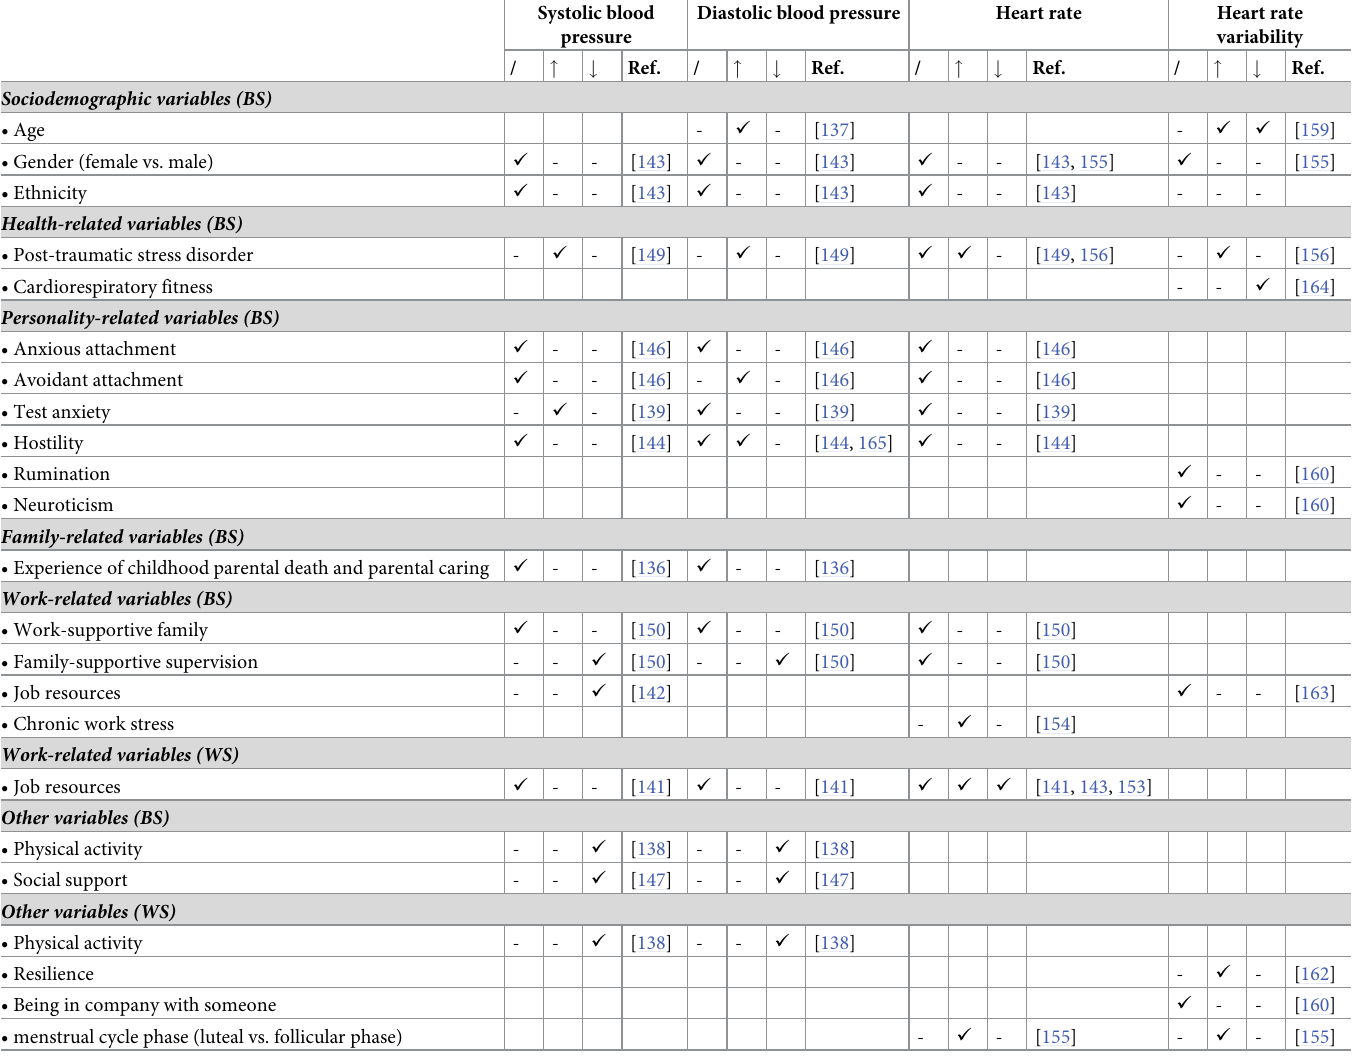
Results . One study found a positive relationship between the diurnal slope of sAA and occurrence of acute stressors regarding marriage [120]. Number of acute stressors during social interactions was not associated with overall levels per day, diurnal slope and next-day awakening response of sAA [166]. Depending on daytime and patient’s type of memory- and behavior-related problems, mixed results regarding associations between diurnal slope of sAA levels and number of acute stressors related to caregiving were obtained [120, 123]. No associa- tion between global subjective stress, severity of acute stressors regarding social interactions and current sAA levels was found [82, 167].